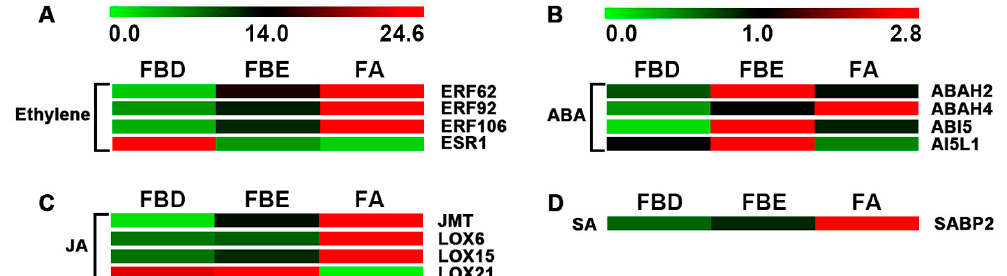
Figure 5. Expression level changes of the DEGs involved in the ethylene-, abscisic acid (ABA)-, jasmonic acid (JA)-, and salicylic acid (SA)-signaling pathways. ( A ) Expression levels of DEGs of ethylene signaling pathways. ( B ) Expression levels of DEGs of ABA signaling pathways. ( C ) Expression levels of DEGs of JA signaling pathways. ( D ) Expression levels of DEGs of SA signaling pathways.